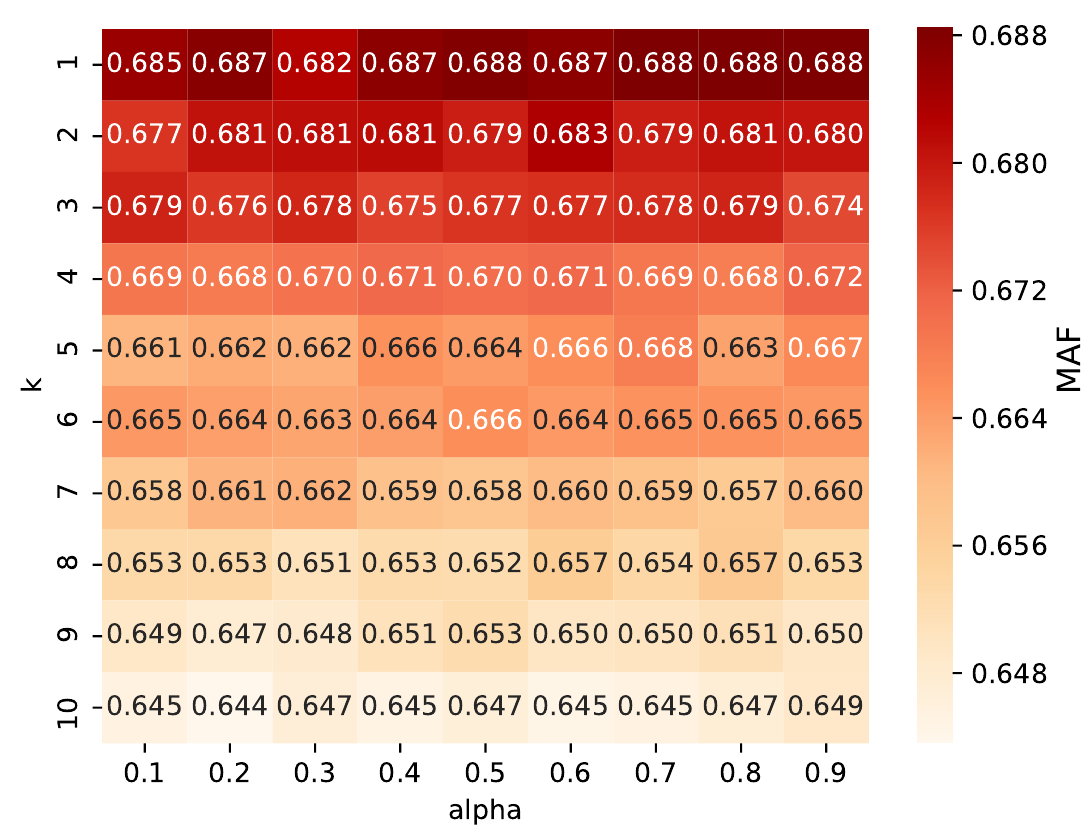
Figure 6. Sensitivity analysis for hyperparameters k and α that determines SAEM, plotted using NC task in Cora